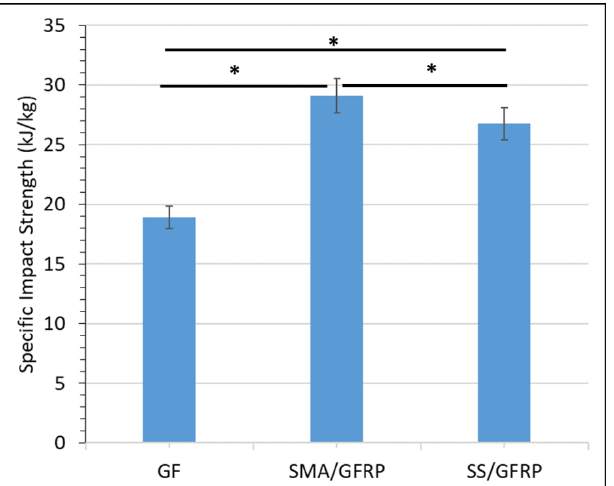
Figure 17. Specific strength of GFRP, SMA/GFRP, and SS/GFRP composites. At a p value of 0.05, specific impact strength is significantly different for all samples. * symbolizes the significant differ- ence.